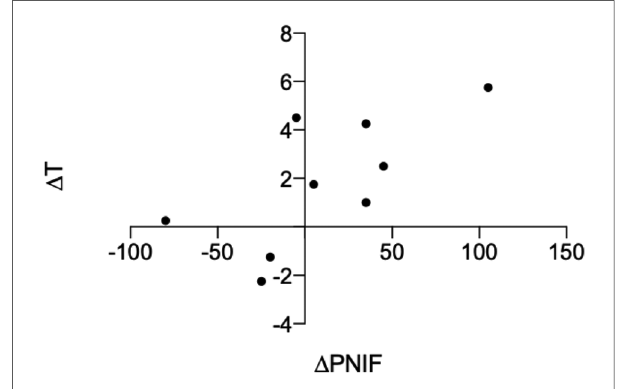
FIGURE 4 Signi fi cant positive correlation between change in PNIF and change in T score after surgery, r =0.68, P